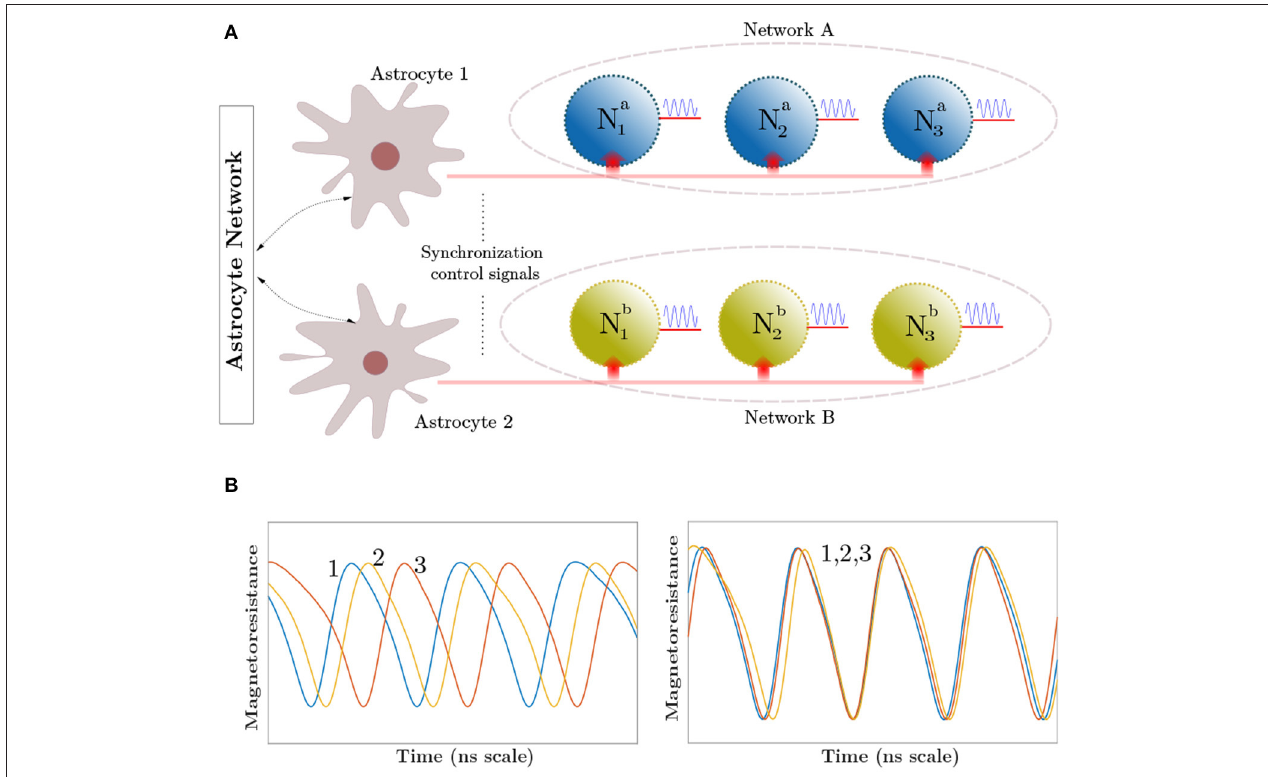
FIGURE 1 | (A) Top-level network depicting the synchronization control by astrocytic injection. Astrocytes share information among their glial network. (B) The curves show the synchronized and unsynchronized outputs of Neurons 1–3 in Network A depending on the astrocyte input.